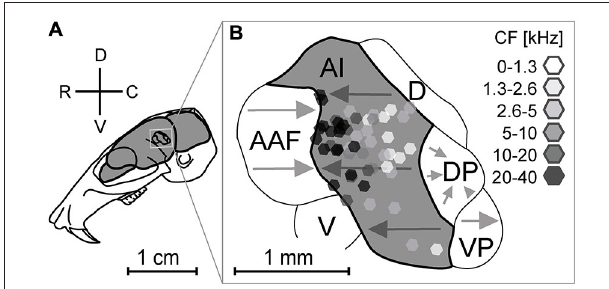
FIGURE 2 | Location of recording sites in relation to the functional organization of the auditory cortex. Location (A) and schematic representation of the parcellation of the auditory cortex (B) . Four subdivisions, AI (primary auditory cortex), AAF (anterior auditory field), VP (ventroposterior field), and DP (dorsoposterior field) show tonotopically organized neurons (gray arrows). The dorsal field (D) and ventral field (V) are not tonotopically organized. All laminar tracks ( n = 51, octagons) were recorded within the AI. Grayscale colors of octagons give the characteristic frequencies. Arrowheads point towards higher frequencies. Adapted from Thomas et al. (1993) and Budinger et al.